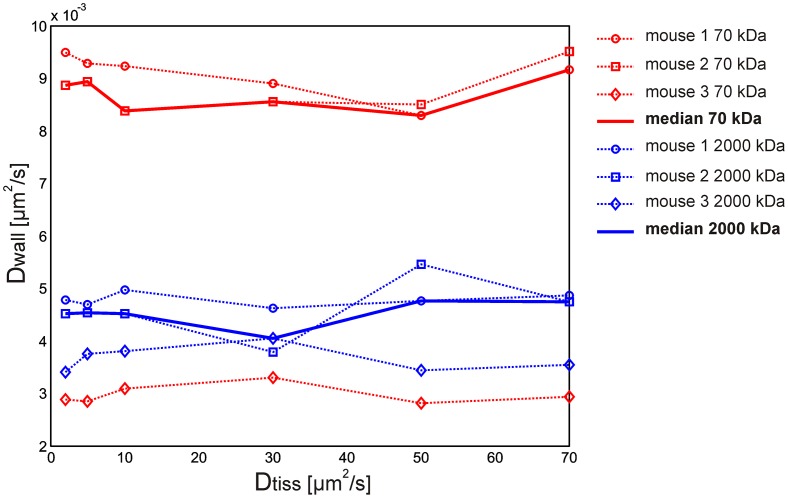
Sensitivity analysis of the calculated apparent diffusion coefficient D
wall.Sensitivity analysis of apparent diffusion coefficient D
wall for 70 kDa and 2000 kDa FD to the values of D
tiss over the range from 2 μm2/s to 70 μm2/s. D
wall(D
tiss) functions calculated for 70 kDa and 2000 kDa FD are represented with red and blue curves, respectively. The bold curves represent the median values of D
wall.